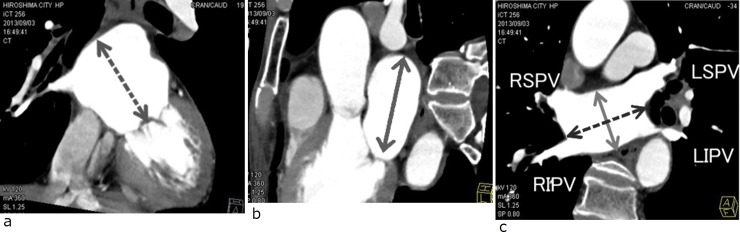
Identification of labeling of the left atrium (LA) in two-dimensional viewing.(a) LA top―mitral annulus diameter (dashed arrow). (b) LA longitudinal diameter (solid arrow). (c) LA anteroposterior diameter (solid arrow) and LA transverse diameter (dashed arrow).